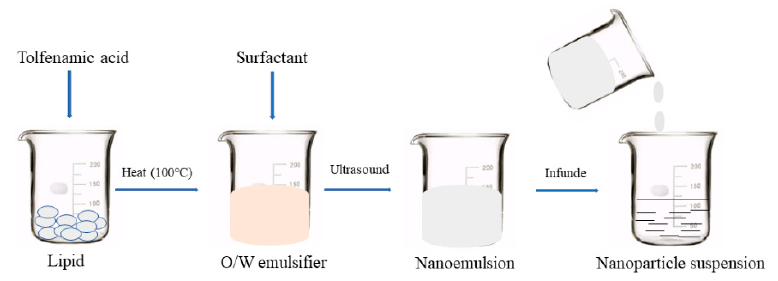
Figure 2. Process flow diagram.